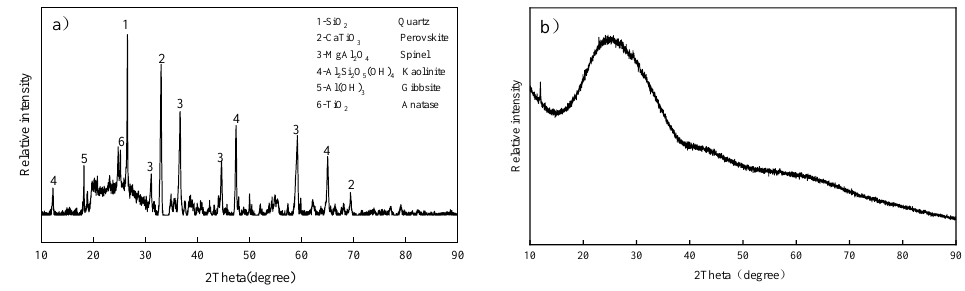
Figure 4. XRD patterns of raw materials: ( a ) polyaluminum chloride slag; ( b ) glass powder.